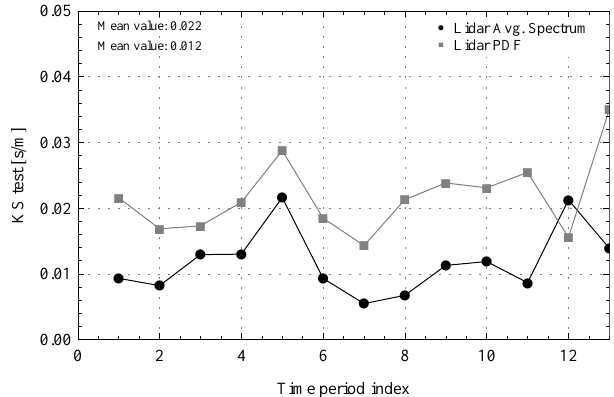
Fig. 5. Kolgomorov–Smirmov test for the two lidar statistical dis- tributions with respect to the sonic cdf using 14 30min